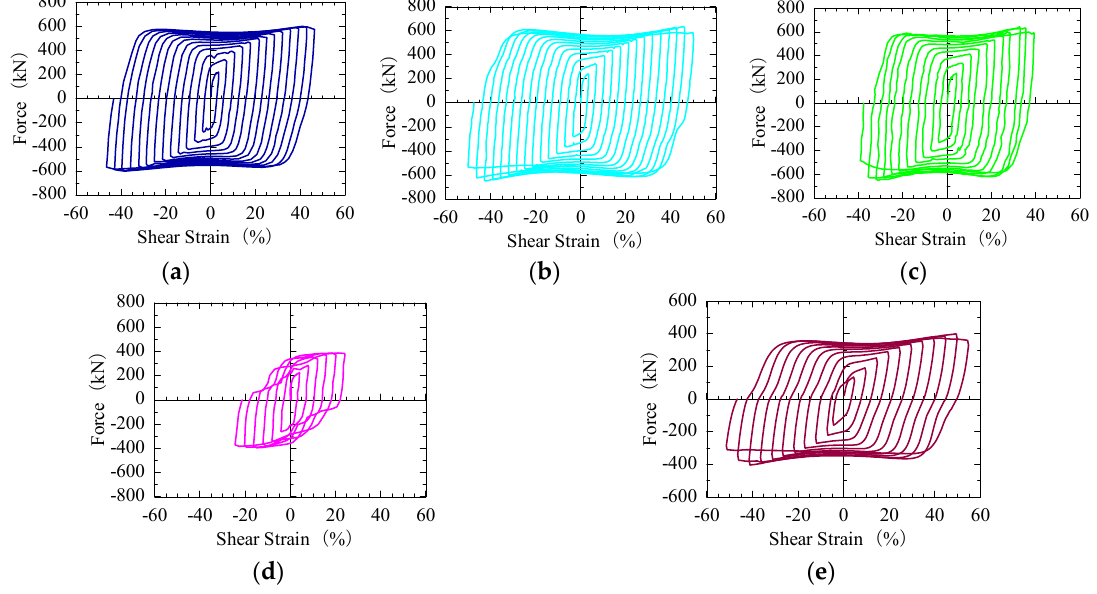
Figure 6. Force–shear strain curves: ( a ) SPD100-50; ( b ) SPD100-28; ( c ) SPD100-10; ( d ) SPD100-rib; and ( e ) SPD160-28.